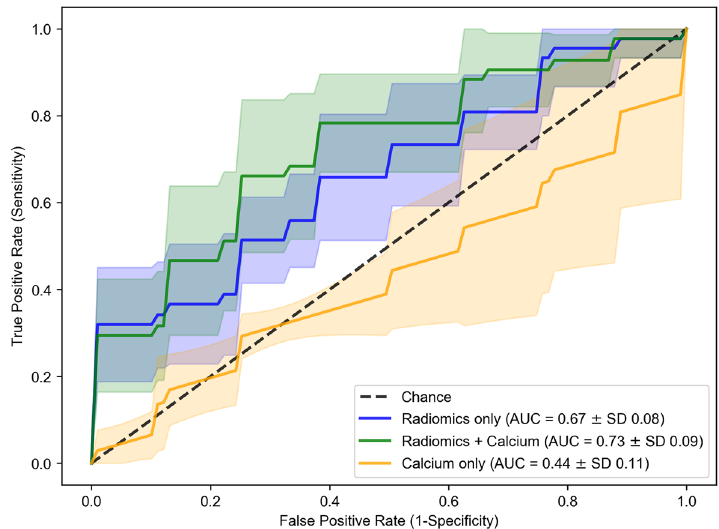
Figure 3. Mean receiver operating characteristic (ROC) curves of five-fold stratified cross-validation in multi- slice analysis with resegmentation for Elastic Net logistic regression (weight for L 1 and L 2 penalties = 0.5) using (1) radiomic features only as predictors, (2) radiomics features and calcium and (3) calcium only. Image setting: multi-slice analysis with resegmentation and a fixed bin width of 25. Dashed line indicates expected AUC for a random chance classifier. AUC, area under the ROC curve; SD, standard